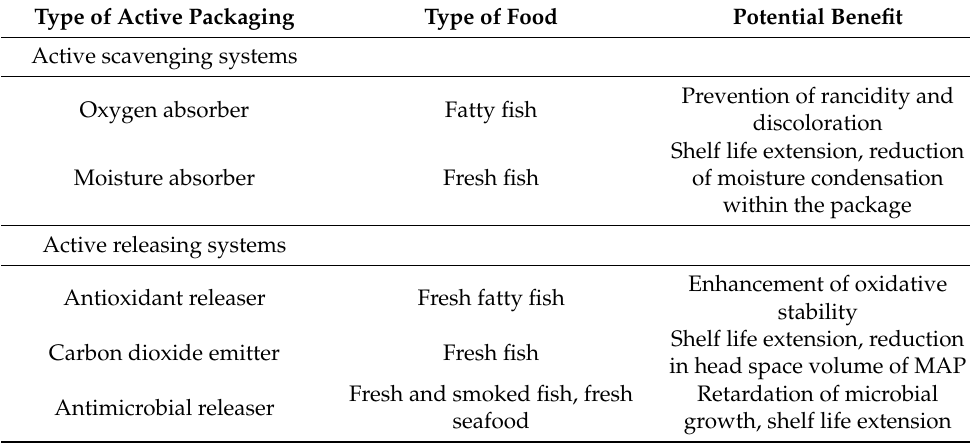
Table 1. Potential active packaging applications for